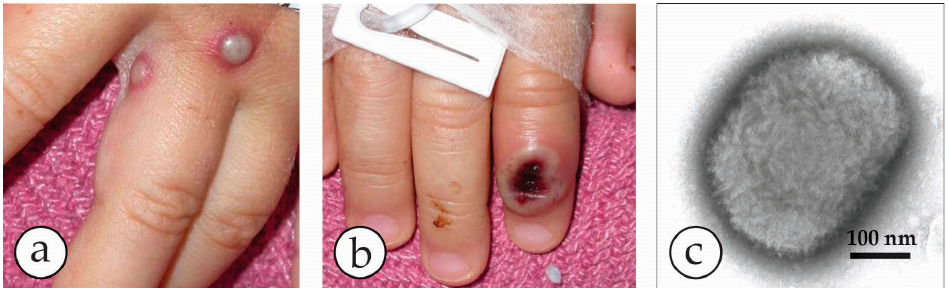
Figure 5. Human monkeypox in the USA in 2003 [36,37]. ( a ) The 2003 multi-state outbreak of human monkeypox in the Mid-West of the USA was initiated by an imported Gambian giant rat carrying MPXV. The rat infected prairie dogs kept as pets and the virus was transmitted to humans as zoonotic infections. The patients developed mild fever, lymphadenopathy and localized lesions where their pet animals had bitten or scratched them. ( b ) Vesicles developed into deep-seated pustules and slightly hemorrhagic ulcers that dried later. ( c ) The etiology remained unclear for 10 days until DEM was used, revealing typical OPV particles. Based on this orientation the final diagnosis of MPXV was confirmed at CDC [37]. Reprinted with kind permission of New England Journal Medicine.